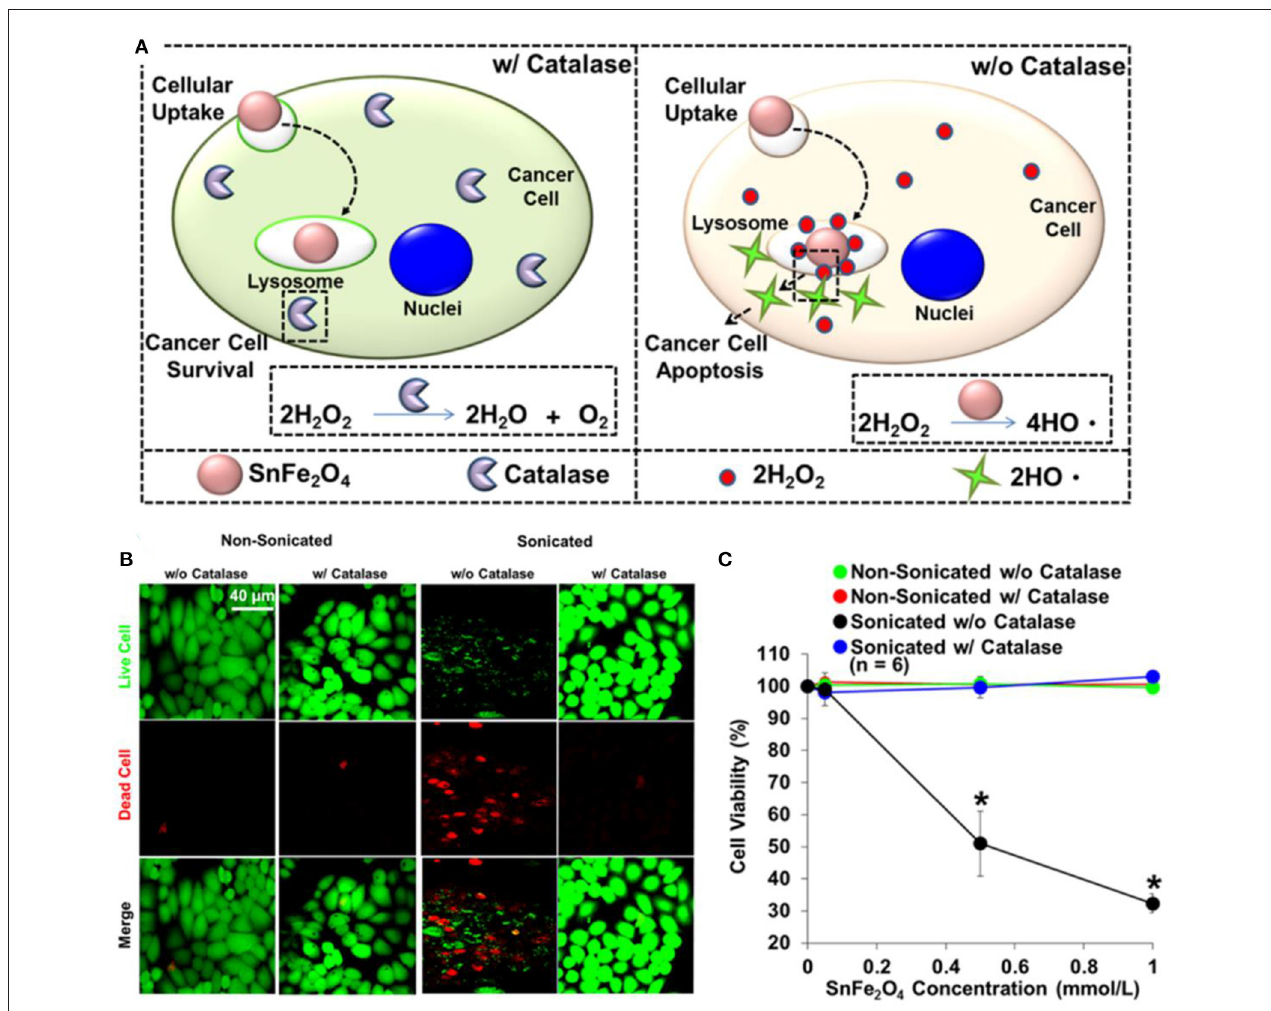
FIGURE 3 | (A) Illustration for cytotoxic effect of SnFe 2 O 4 nanocrystals on cancer cells. (B) Fluorescent images of test cells. (C) Corresponding quantitative results obtained using MTT. *Statistical significance indicated by P < 0.05. Reproduced, with permission, from Lee et al. (2017). Copyright 2016, American Chemical